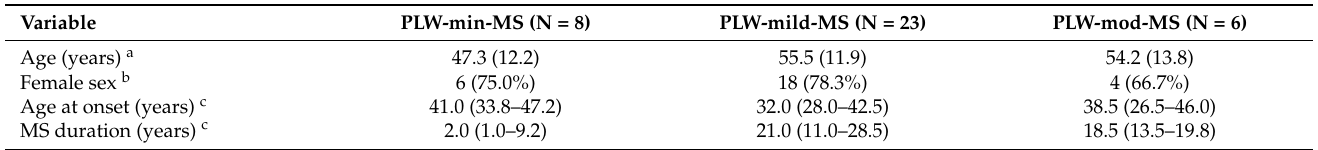
Table 1. Participant Characteristics.